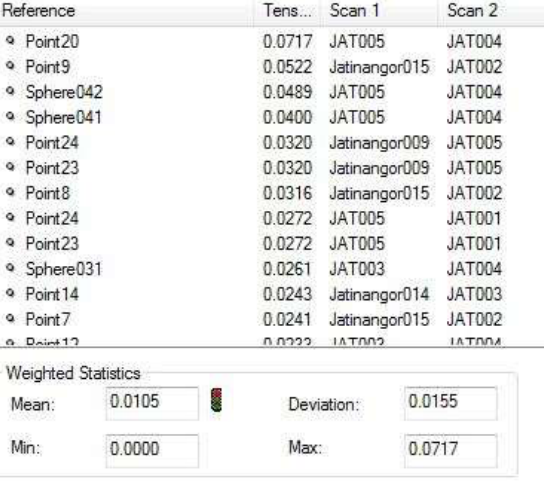
Figure 8. Control Points Accuracy of TLS